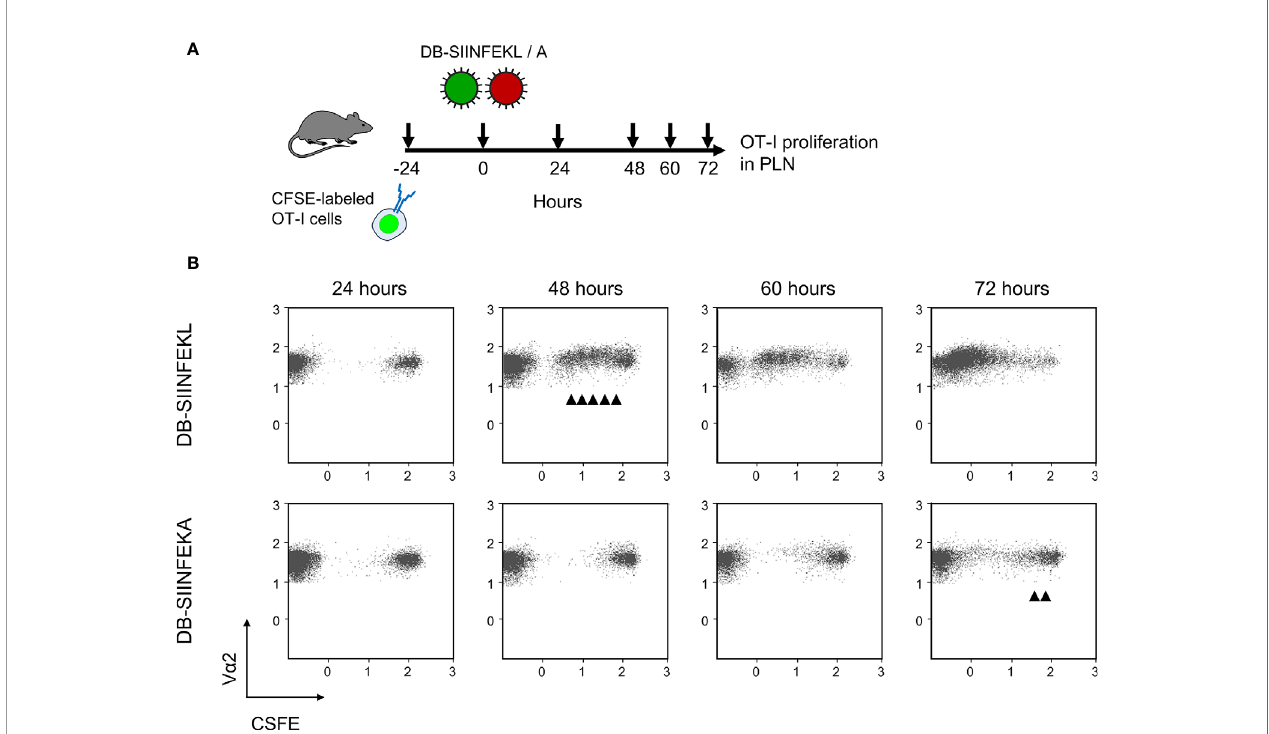
FIGURE 9 | DB-driven epitope-speci fi c proliferation of transferred OT-I cells. (A) Experimental protocol. Fluorescence-labeled OT-I cells were transferred intravenously into immunocompetent C57BL/6 mice. Proliferation of OT-I cells recovered from the draining ipsilateral popliteal lymph node (from three mice pooled) was measured at the indicated times after intraplantar priming (vaccination) with 20- m g doses of DB-SIINFEKL or DB-SIINFEKA. (B) Cyto fl uorometric measurement of the loss of the fl uorescence label due to the proliferation of OT-I cells over time. (Ordinate) fl uorescence speci fi c for the V a 2 TCR chain expressed by OT-I cells. (Abscissa) CFSE fl uorescence. For groups of most interest, arrowheads mark cell